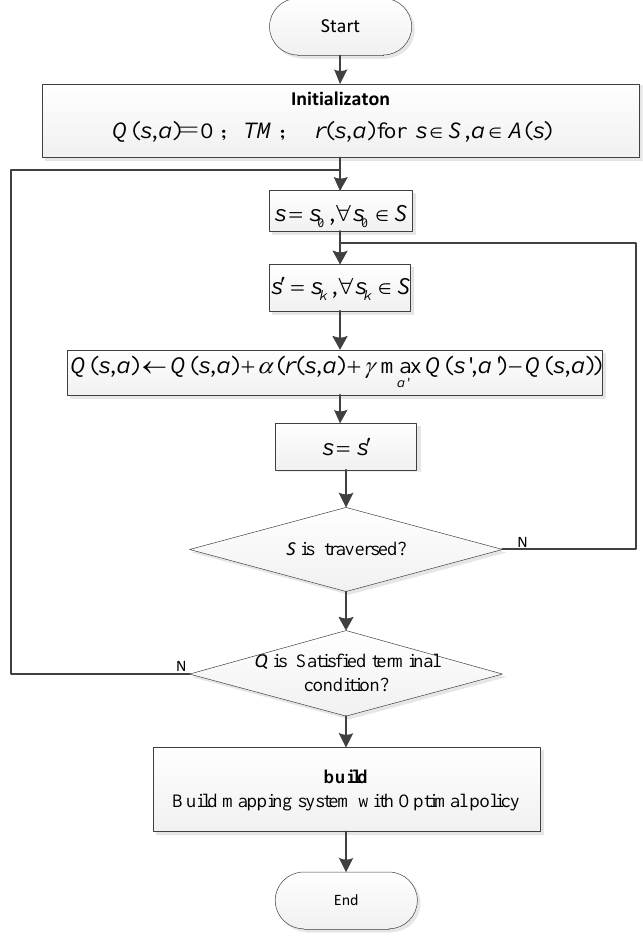
Figure 5. Markov Decision Construction (MDC) procedure.